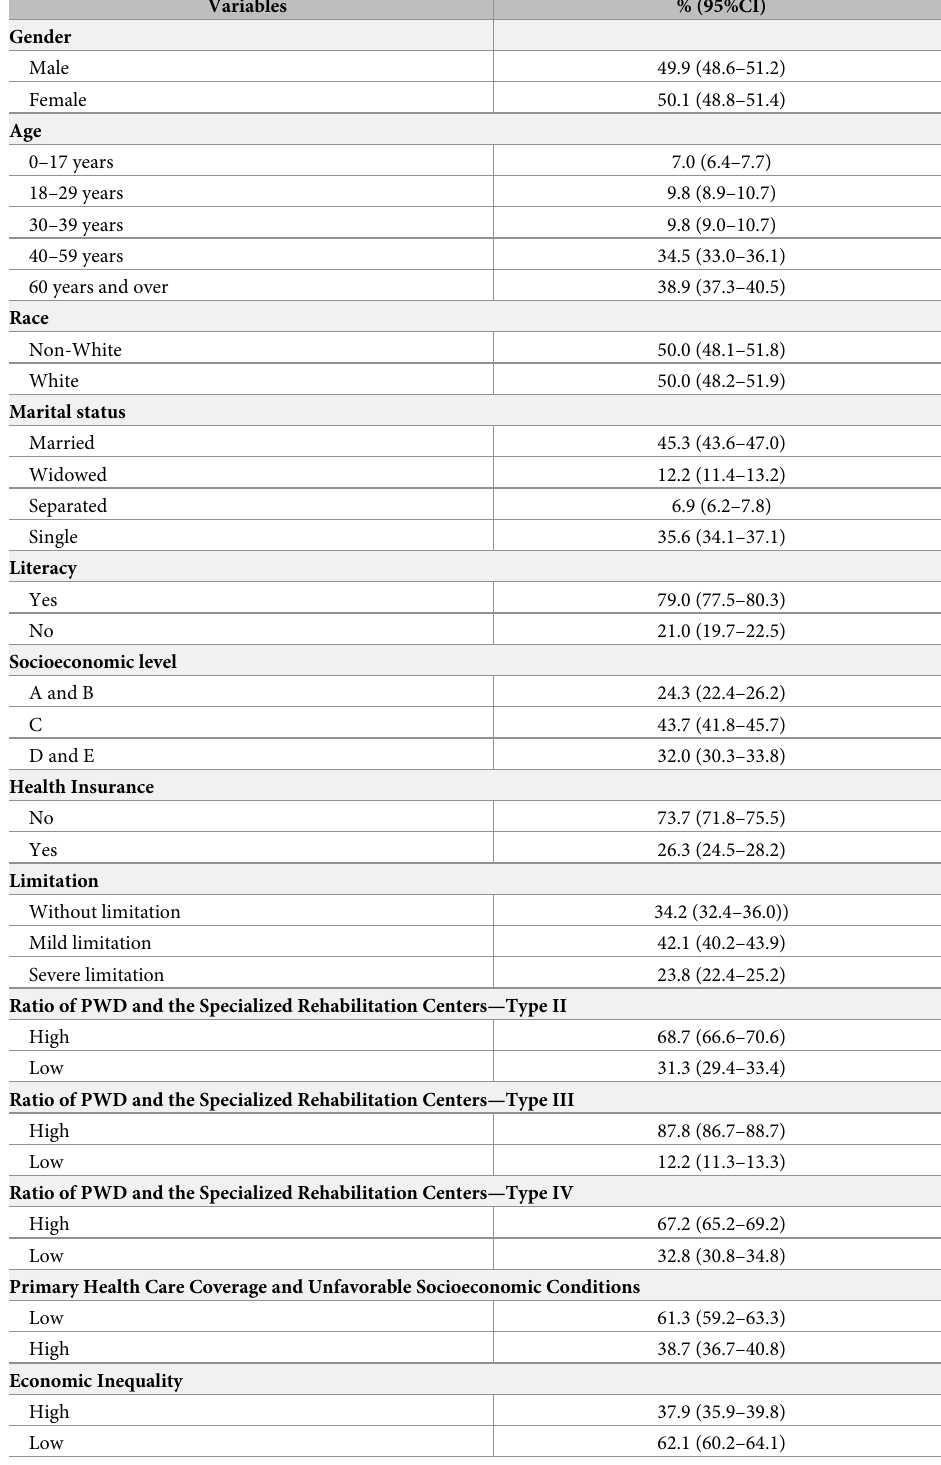
Table 3. Prevalence of people with disabilities according to the study variables. Brazil,